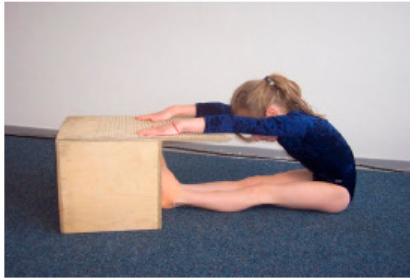
Figure 5. Test setup ‘Sit-and-reach’, ©Testmanual KiMo-Test; Dr. rer. nat. S. Dordel, Dr.